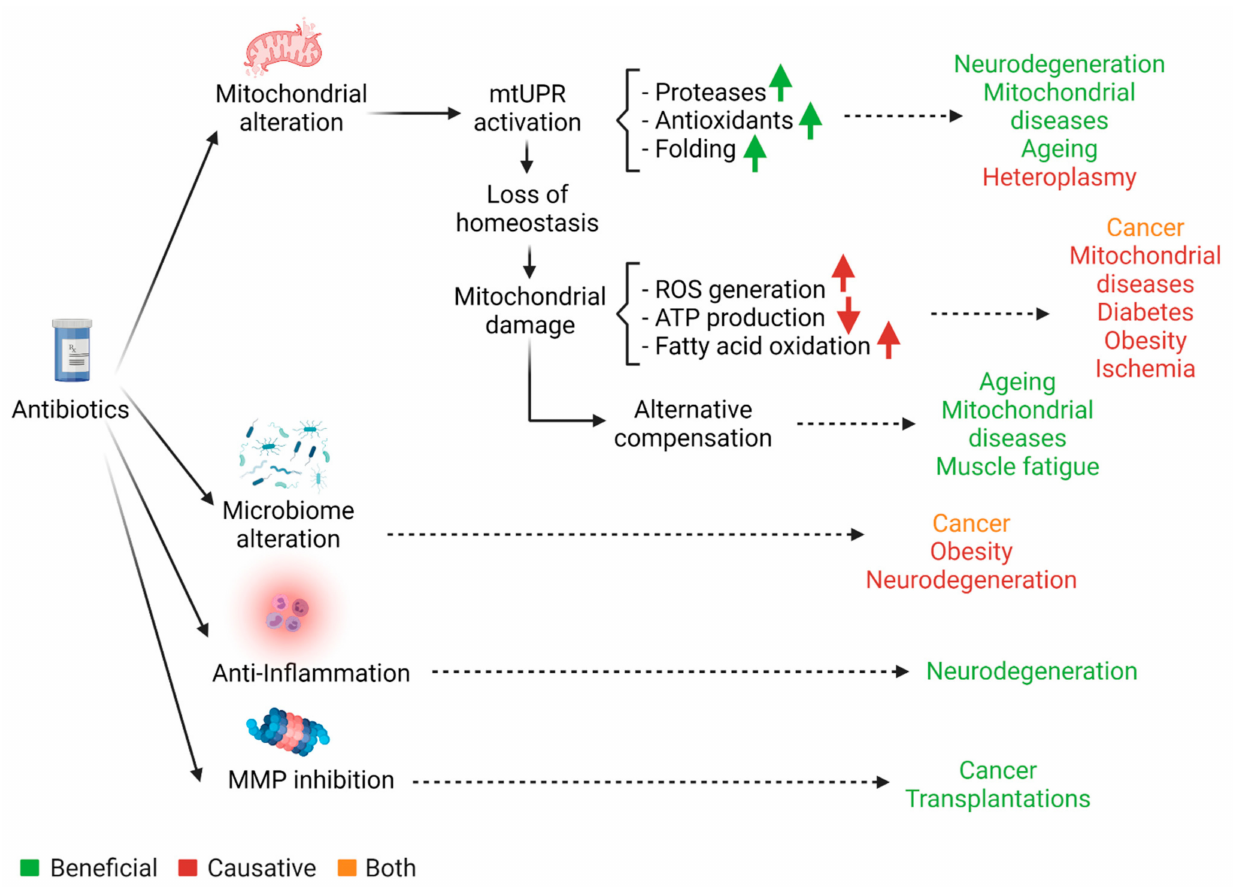
Figure 1. Schematic representation of antibiotics’ general pleotropic effects. Although antibiotics are classically known for their microbicidal or bacteriostatic usage, several studies show that these drugs present numerous pleiotropic effects. Interestingly, these features might represent a potential therapeutic tool, reason why they deserve further consideration and